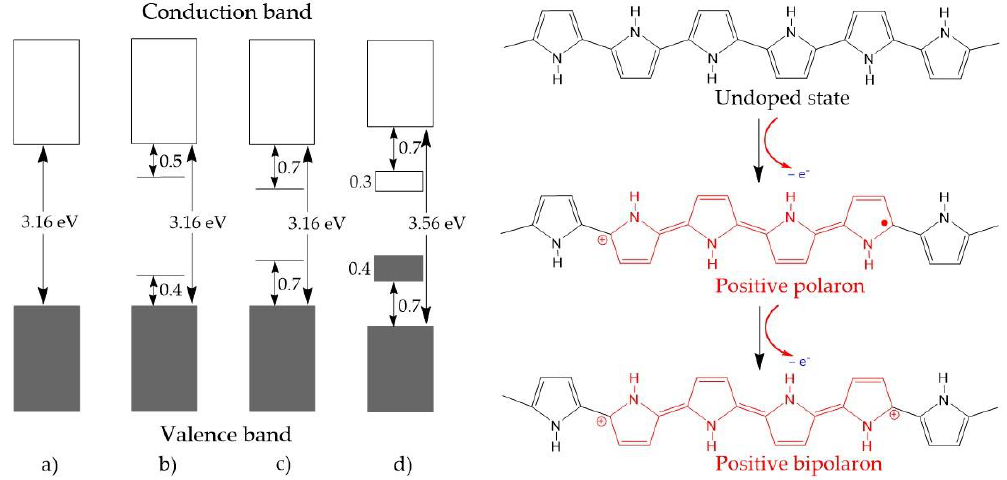
Figure 3. Electronic bands and chemical structures illustrating ( a ) undoped; ( b ) polaron; ( c ) bipolaron; and ( d ) fully doped states of polypyrrole (PPy).